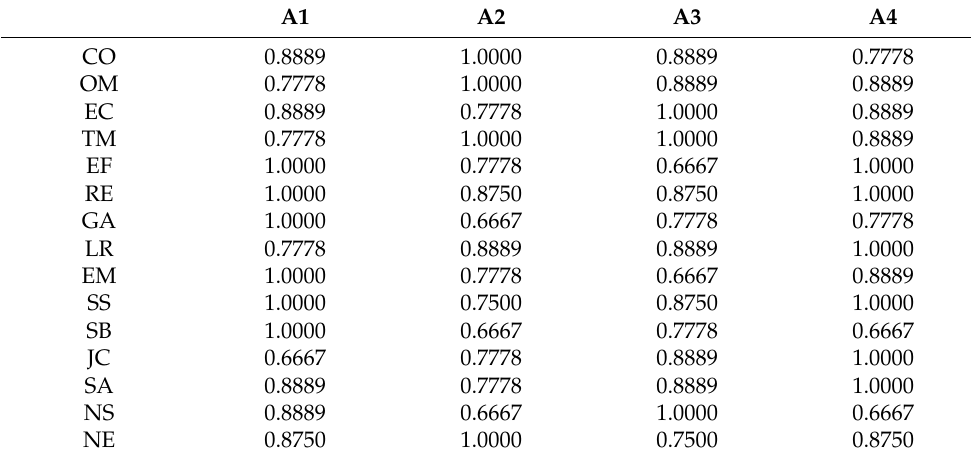
Table 5. Normalized Matrix.